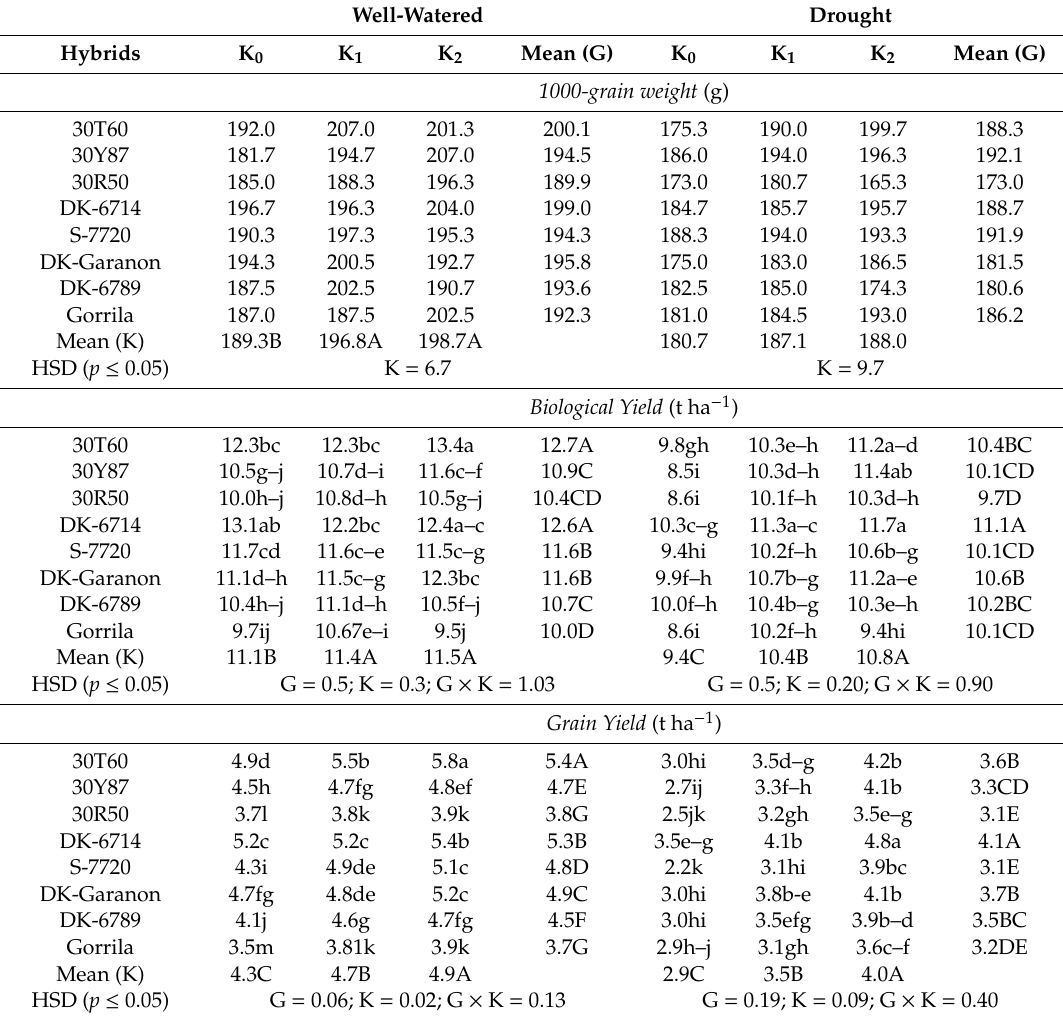
Table 3. Influence of various potassium levels on 1000-grain weight, biological yield, grain yield, and water productivity of various maize hybrids under well-watered and drought stress